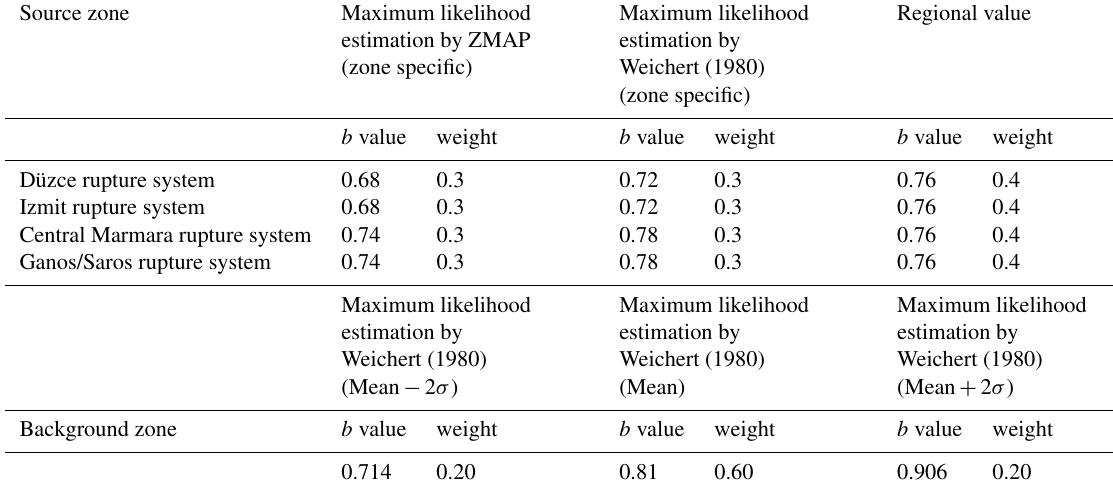
Table 2. b values estimated using different methods and corresponding weights in the logic tree. Maximum likelihood Source zone Maximum likelihood estimation by estimation by ZMAP Weichert (1980) (zone specific) b value weight b value weight weight Düzce rupture system 0.68 Izmit rupture